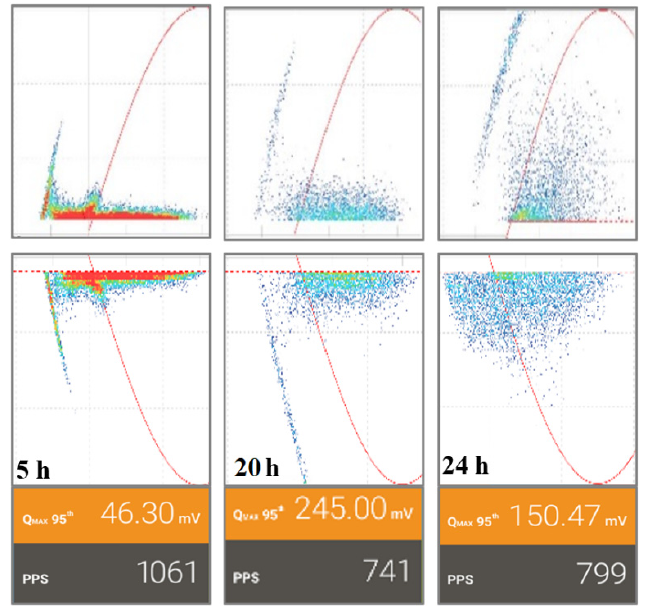
Figure 5. Sinusoidal voltage PRPD patterns acquired after 5, 20 and 24 h of voltage application. To save space compared to Figure 4, the PRPD patterns positioned in the upper part are referred to as the positive half-wave, whilst those in the bottom part are referred to as the negative half-wave.